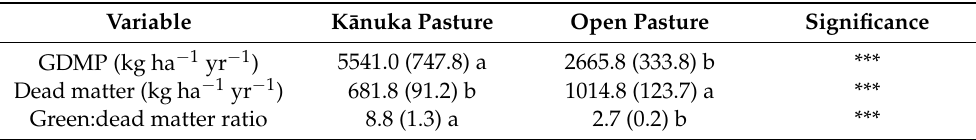
Green:dead matter ratio *** Different letters represent significant differences between the treatments; *** = p < 0.001